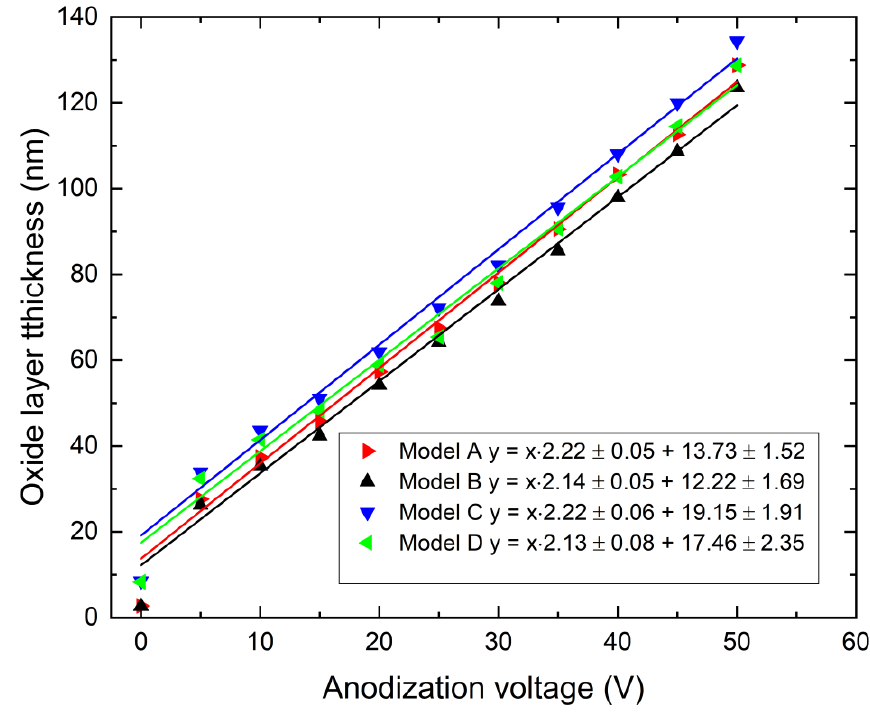
Figure 3. Ellipsometric measurements of oxide film growth in 1 M H 2 SO 4 on mechanically polished Nb anode vs. applied voltage for various optical constants shown in Table 1.